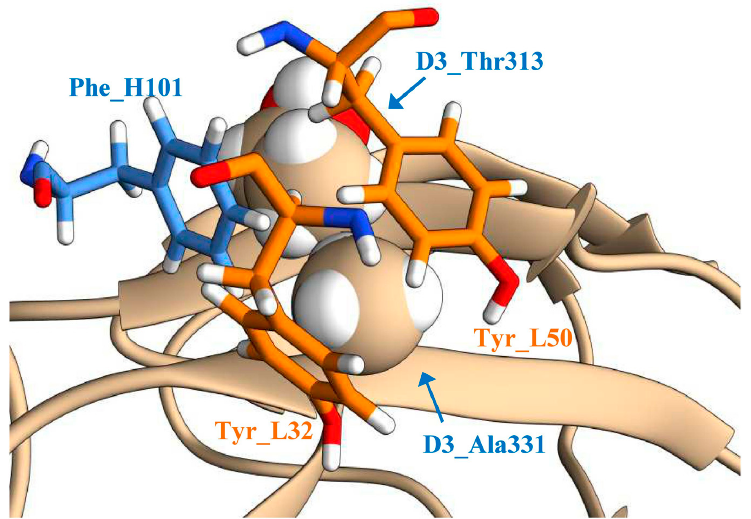
Figure 1. The structure of the antibody − antigen interface adjacent to the Ala331 residue of the D3_Sof protein: The amino acid residues Tyr_L32 and Tyr_L50 of the light chain are shown in orange; the amino acid residue Phe_H101 of the heavy chain of the ch14D5 antibody is shown in blue; part of the D3_Sof protein is shown in tan.